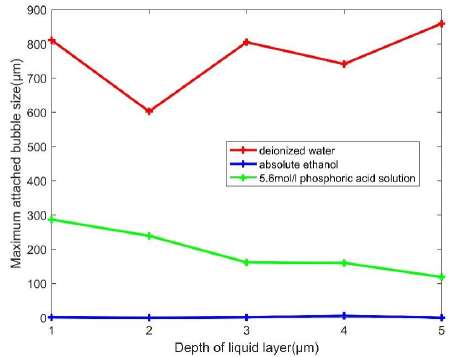
Figure 4. Maximum attached bubble sizes under different liquid mediums and depths of liquid layer at the end of 2-second machining.